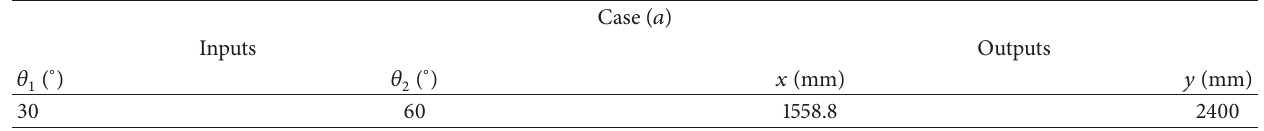
Table 1: Forward position analysis for the